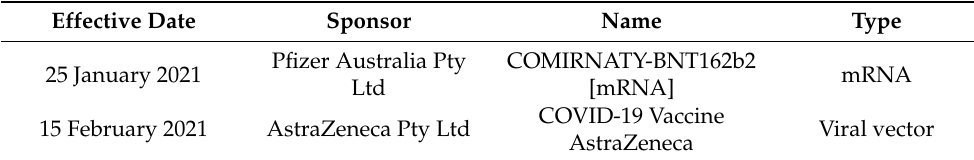
Table 3. Accessible vaccines through provisional registration [69]. Last updated 22 May